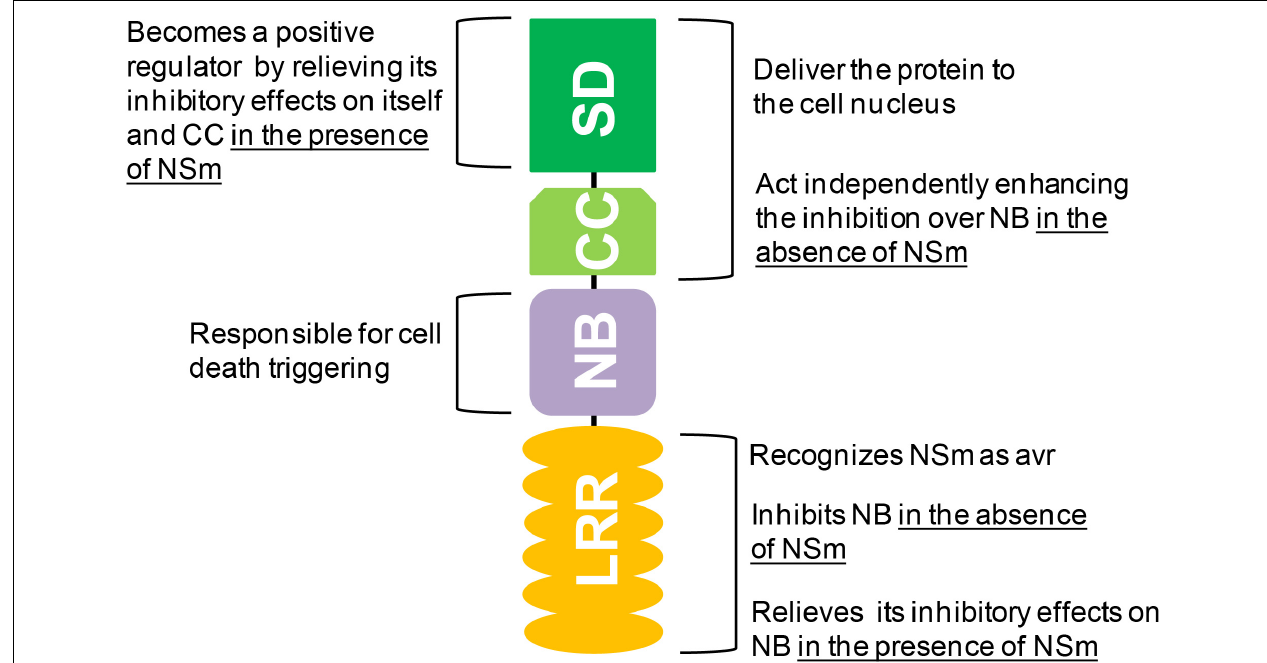
FIGURE 1 | Overview of the (modulating) roles of the amino-terminal Solanaceae (SD) and coiled-coil (CC), central nucleotide-binding (NB), and carboxy-terminal leucine-rich repeat (LRR) domains in Sw-5b activation. Detailed information is found in the manuscript text.